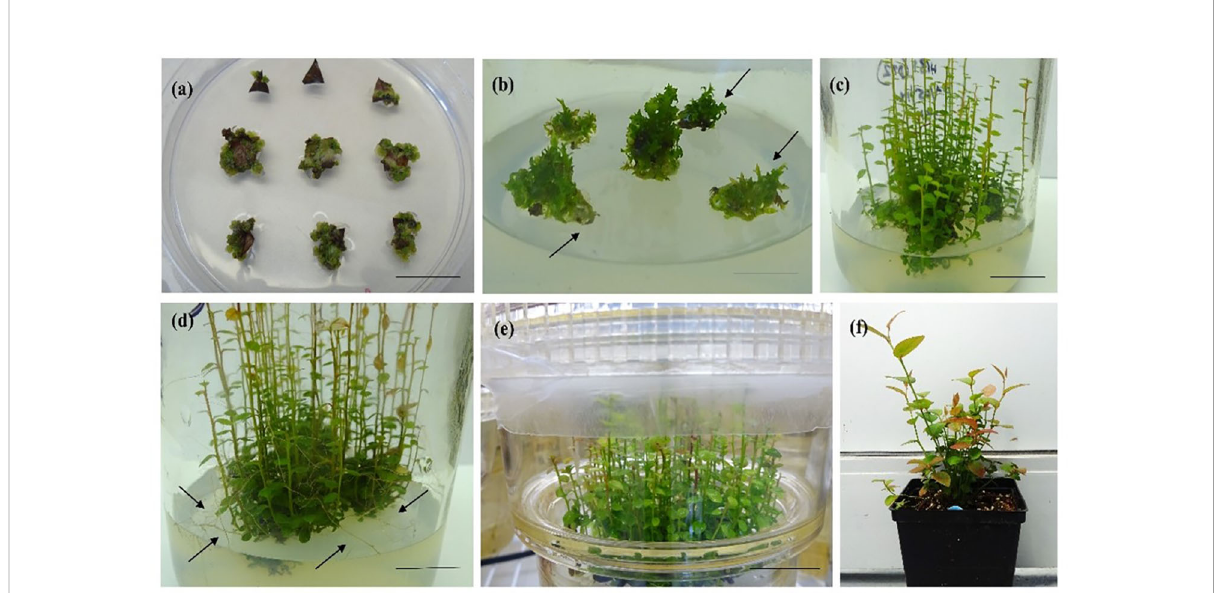
FIGURE 1 In vitro organogenesis in half-high blueberry cv. “ Patriot ” . (A) Callus formation after 4 weeks of culture on a semisolid medium (SSM) with 2.3 µM ZEA (bar = 2 cm), (B) bud initiation from callus (arrows) after 8 weeks of culture on SSM with 9.2 µM zeatin (bar = 2 cm), (C) shoot regeneration after 12 weeks of culture on SSM with 9.2 µM zeatin (bar = 2 cm), (D) shoot elongation and root formation (arrows) after 16 weeks of culture on SSM with 9.2 µM zeatin (bar = 2 cm), (E) shoot elongation after 16 weeks of culture in a temporary immersion bioreactor (TIB) containing a liquid medium with 9.2 µM zeatin (bar = 3 cm), and (F) 1-year-old hardened-off plants in a greenhouse (bar = 8